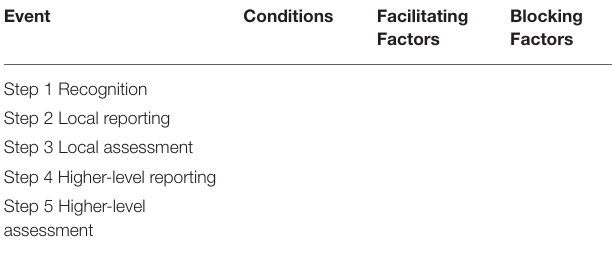
TABLE 1 | Five-step detection model with conditions and influencing